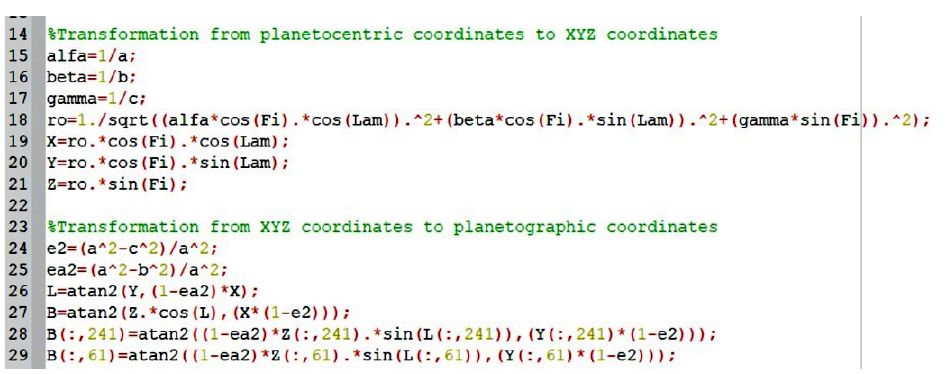
Fig. 3. Converting the planetocentric coordinates into rectangular coordinates X, Y, Z, and then into planetographic coordinates